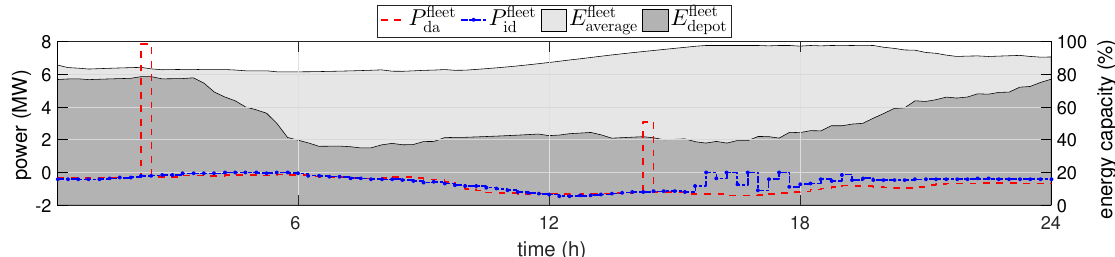
Figure 9. Day-ahead (da) and intraday (id) charging schedules and normalized energy capacity of the spatial and temporal available electric vehicle